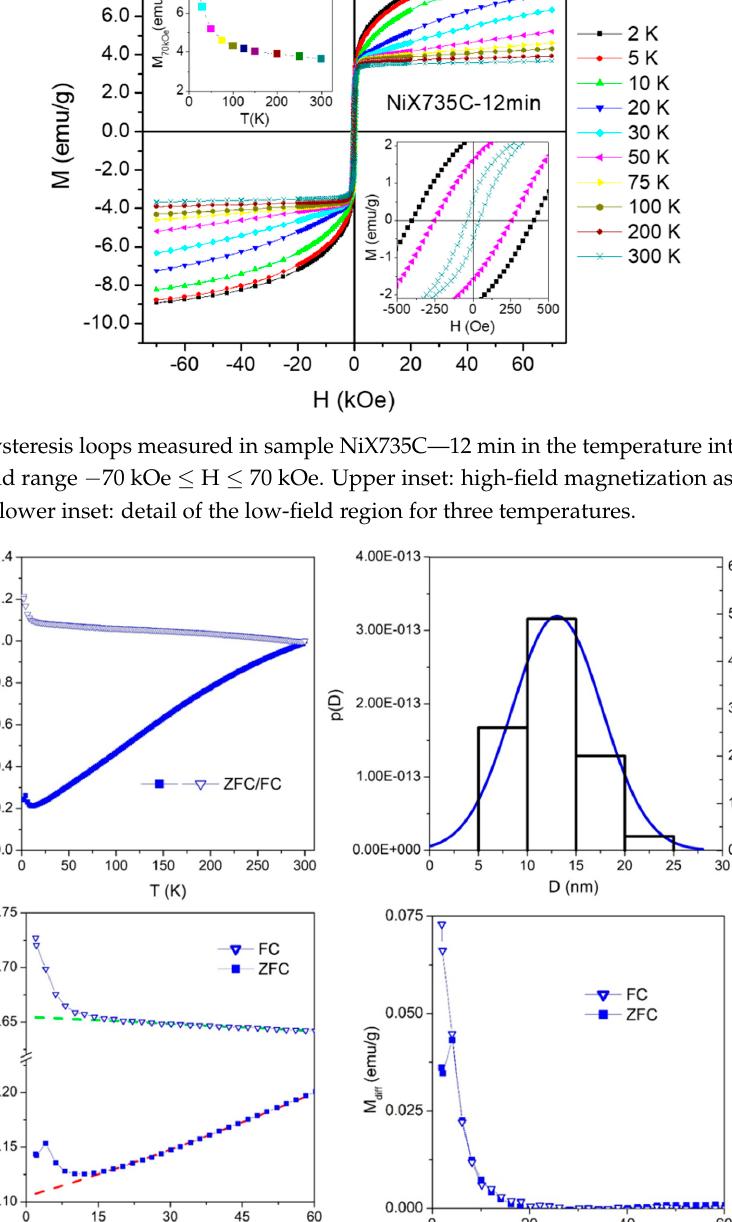
Figure 16. ( Top left ) FC/ZFC curves of sample NiX735C—12 min; ( top right ) NP size distribution derived from the ZFC curve analysis (blue line), superimposed to the experimental histogram (Figure 13d); ( bottom left ) magnification of the low-temperature structures of FC/ZFC curves in sample NIX735C—12 min; ( bottom right ) low-temperature structures resulting after subtraction of the baseline.